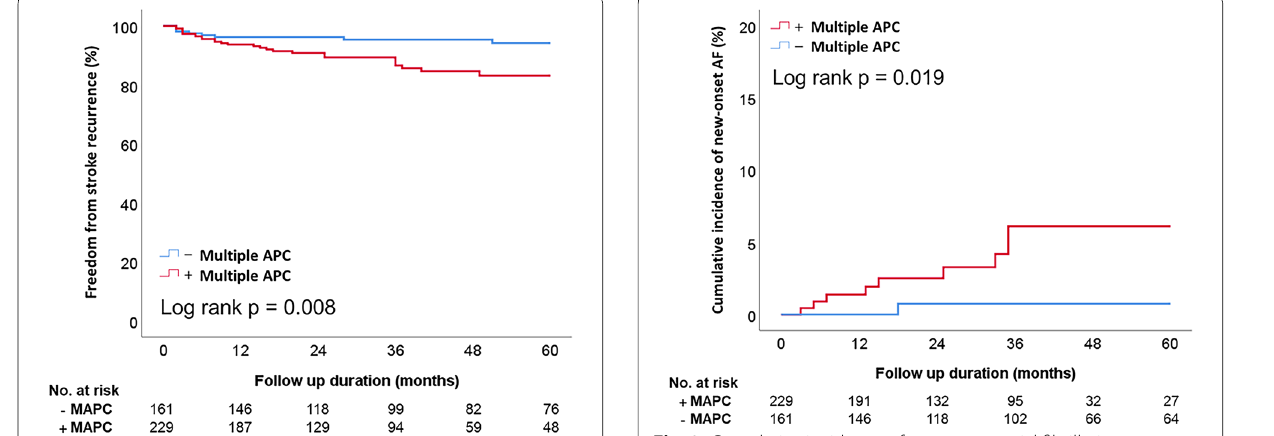
Table 2 Cox proportional hazards regression analysis of predictors of stroke recurrence Univariate